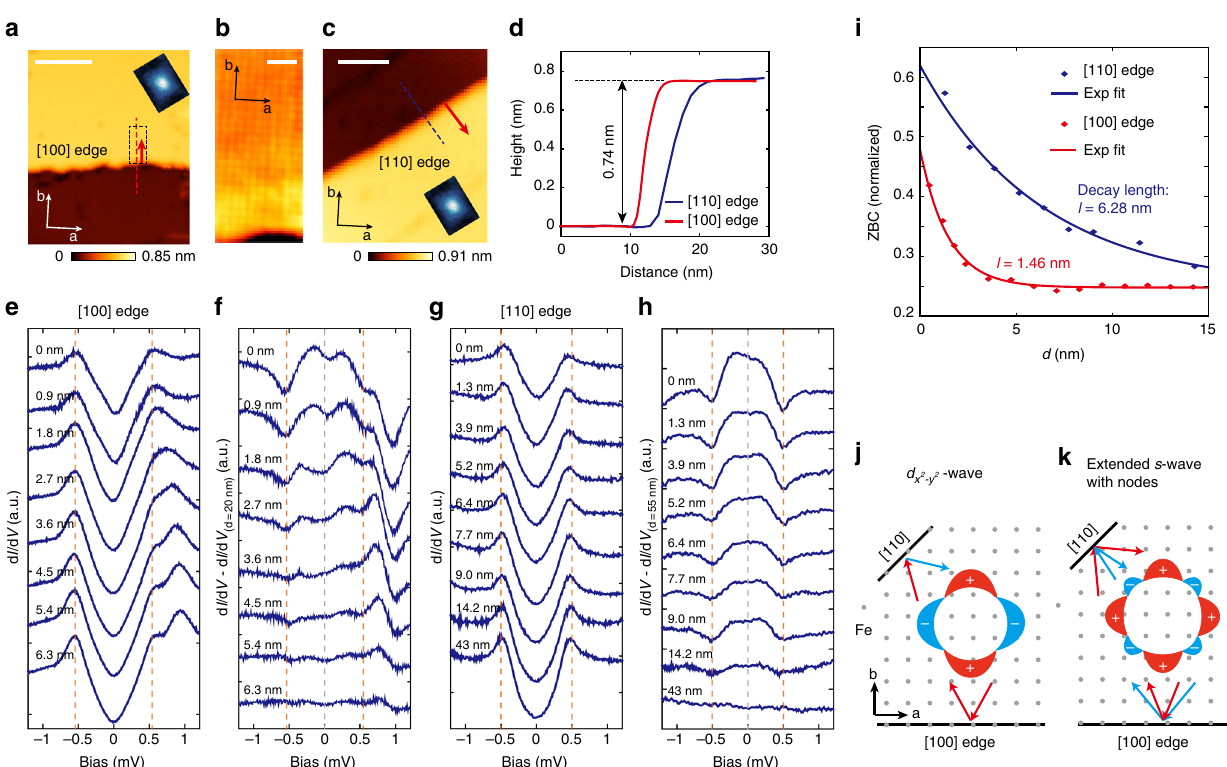
Fig. 5 Effect of atomic step edges on superconductivity. a Topography of a step edge along [100] direction ( V b = 0.5 V, I = 10 pA, scale bar: 20 nm). b Atomically resolved image near the [100] edge ( V b = 2 mV, I = 200 pA, scale bar: 2 nm), taken in the dashed rectangle in panel a . c Topography of a step edge along [110] direction ( V b = 0.5 V, I = 10 pA, scale bar: 20 nm). The orientation of the steps in panel a and c relative to the C 4 symmetry breaking is indicated by the inserted vortex core images. d Line pro fi les along the dashed lines marked in panels a and c , showing that both steps are half a unit cell high. e , f Superconducting gap evolution when leaving the [100] step edge (along red arrow in panel a , setpoint: V b = 1.5 mV, I = 80 pA, Δ V = 50 μ V). A gap far from the step edge has been subtracted for panel f . Dashed lines mark the position of coherence peaks and E F . g , h Superconducting gap evolution when leaving the [110] step edge (along red arrow in panel of c , setpoint: V b = 1.5 mV, I = 100 pA, Δ V = 50 μ V) and the subtracted spectra. i ZBC decay evolution when leaving different steps (dots) and their exponential fi ts (solid lines). j , k Demonstration of the quasi-particle scattering on step edges with different orientation and pairing symmetry. j d x 2 (cid:1) y 2 -wave pairing. k extended s -wave pairing with eight accidental nodes. (All the data shown in this fi gure are taken at T = 20 mK ( T eff = 310